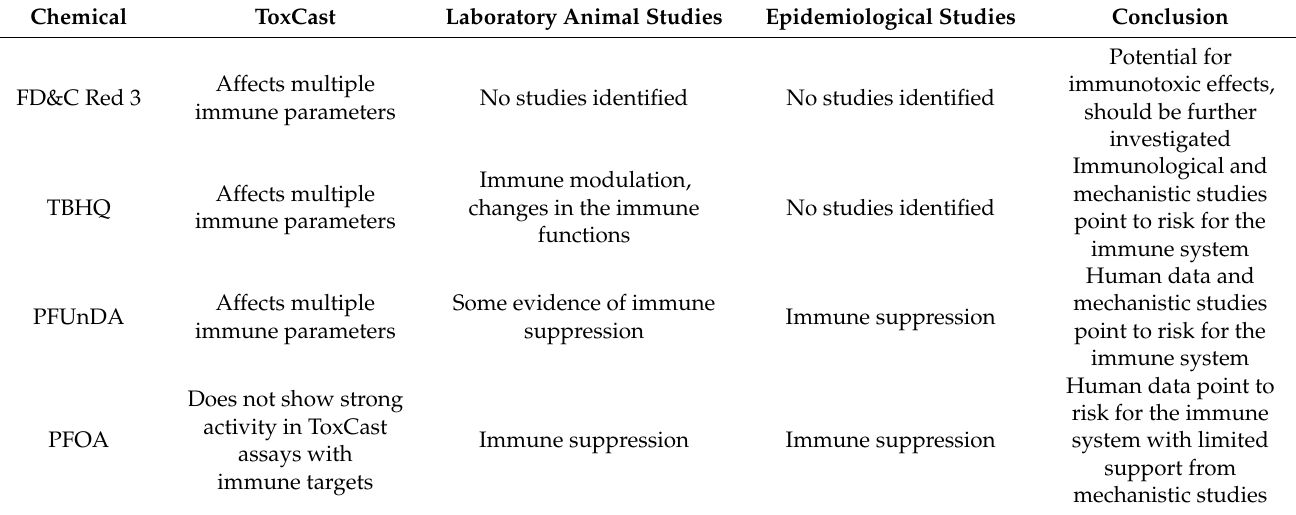
Table 7. Summary of findings comparing high-throughput data with other data